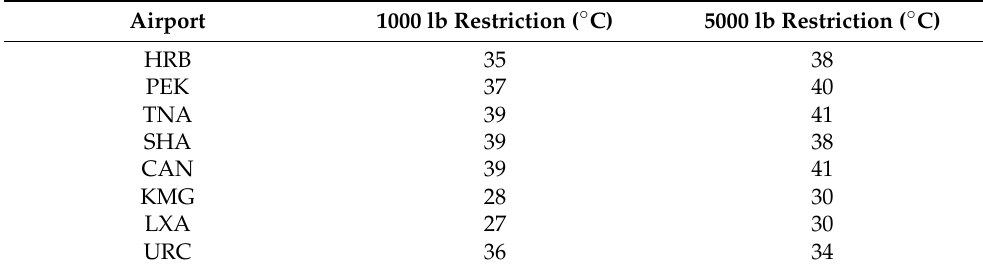
Table 2. Temperature thresholds for two levels of weight limitation for Boeing 737-800.